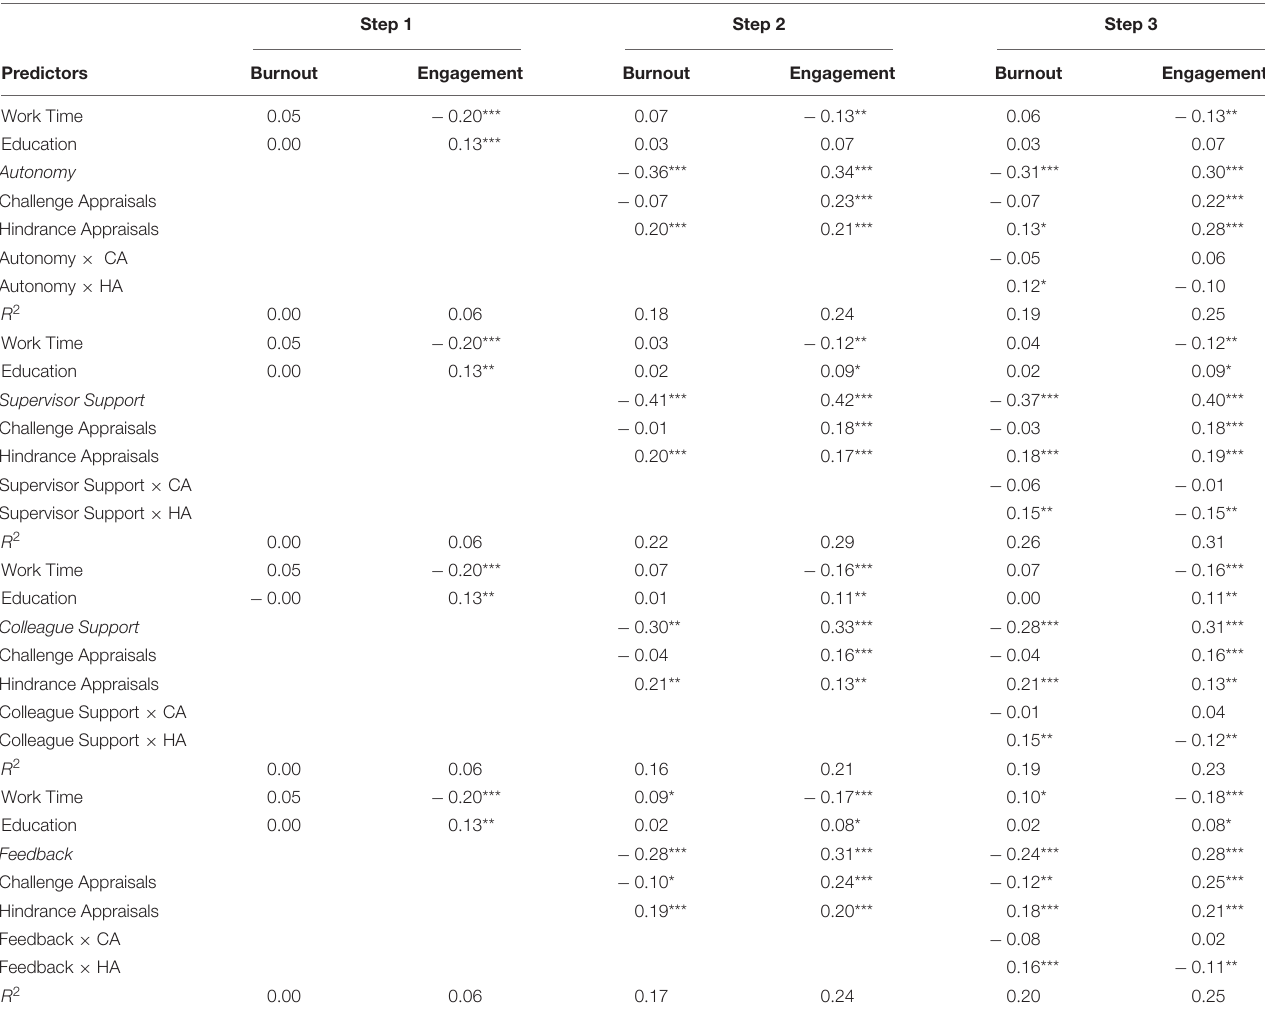
TABLE 4 | Regression results for the moderation of appraisals on the relationships between job resources and work engagement/Burnout in Study 1. Step 1 Step 2 Step